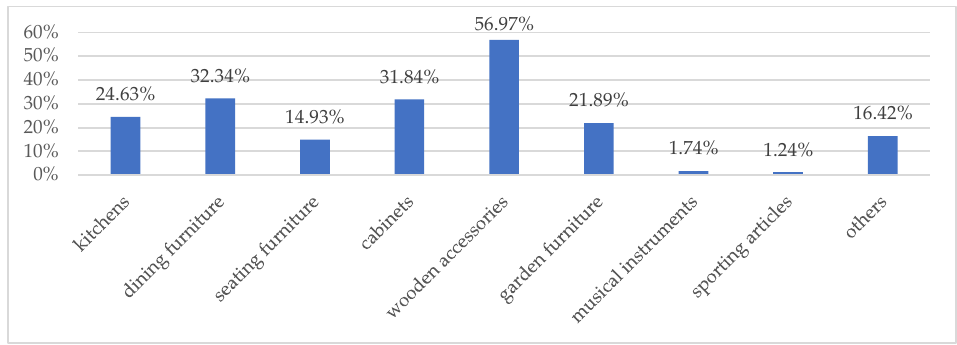
Figure 3. Supply of wood products treated by dyeing.